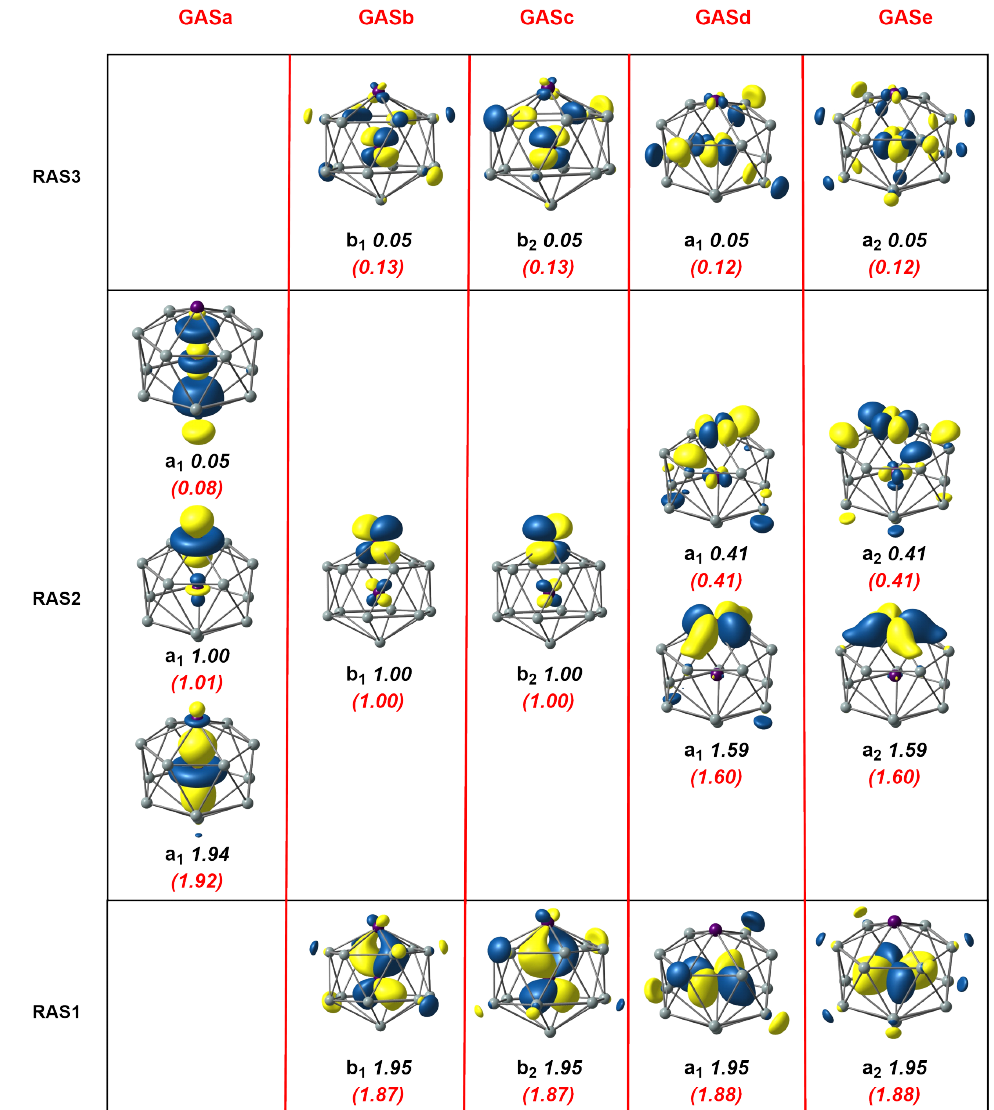
Figure 4. Natural orbitals and occupation numbers for the restricted active space (horizontal) and generalized active space (vertical) of [Mn space calculation are mentioned in brackets. Calculations on [Mn than the full C 6 v point